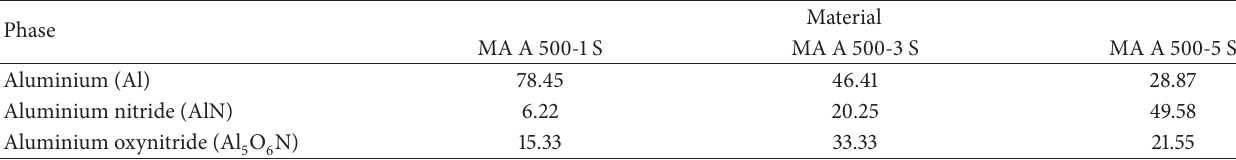
Figure 5: X-ray diffraction of as-milled and as-sintered Al powders milled for 5h (a) in vacuum and (b) in ammonia gas flow. Table 1: Phases present vol.% in sintered Al powders milled in an ammonia gas flow at 500 rpm for 1, 3, and 5 h (MA A 500-1 S, MA A 500-3 S, and MA A 500-5